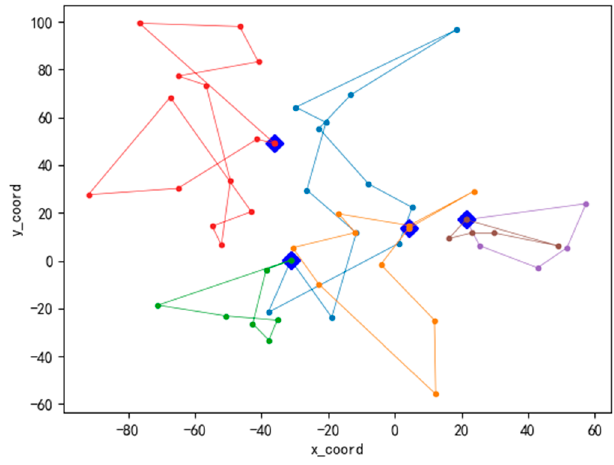
Figure 9. Convergence curve of HALNS.